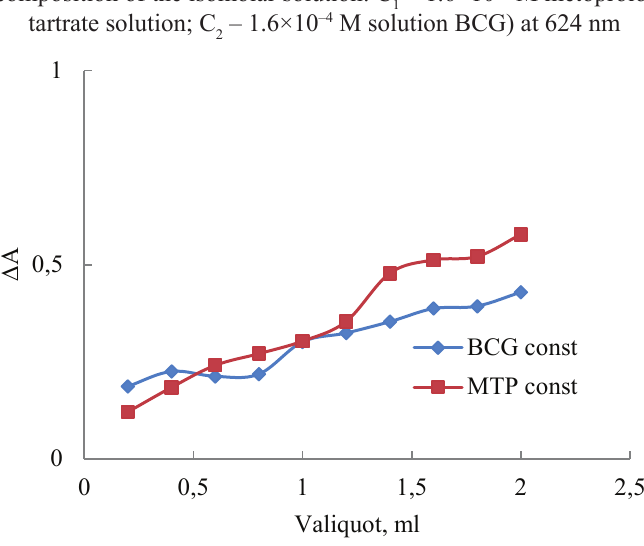
Fig. 4. Saturation curves: metoprolol tartrate solution at a constant concentration of reagent (1.00 mL of 1.6×10 –4 M solution), BCG solution at a constant concentration of metoprolol tartrate (1.00 mL